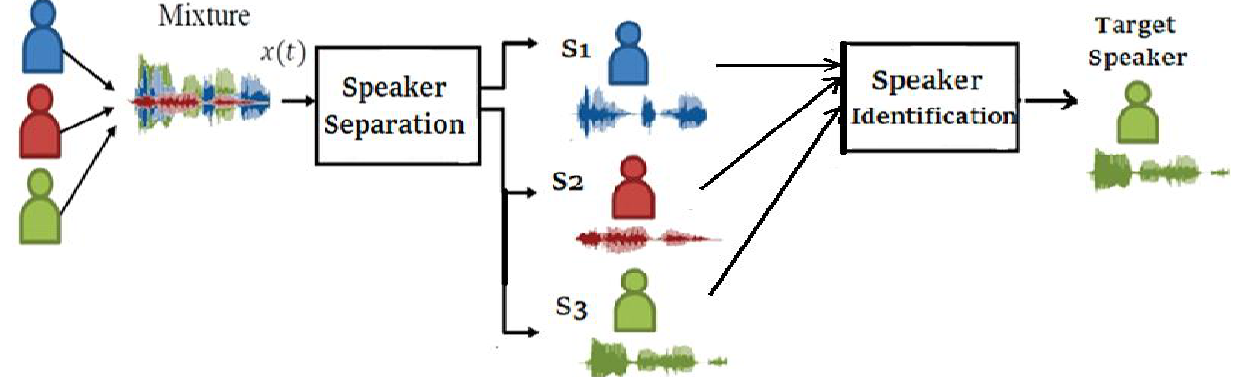
Figure 2. Proposed model integrated with speaker separation and identification for real-time application.